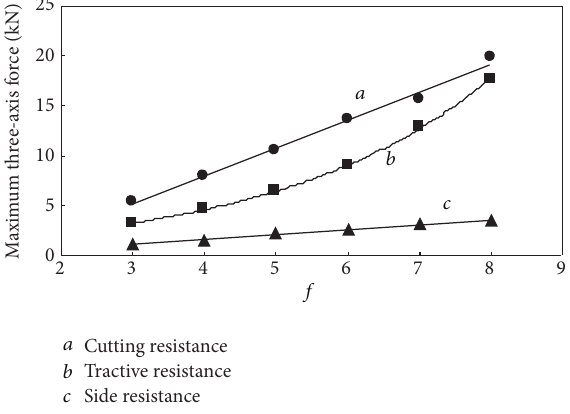
Figure 9: Relationship between maximum three-axis force and 𝑓